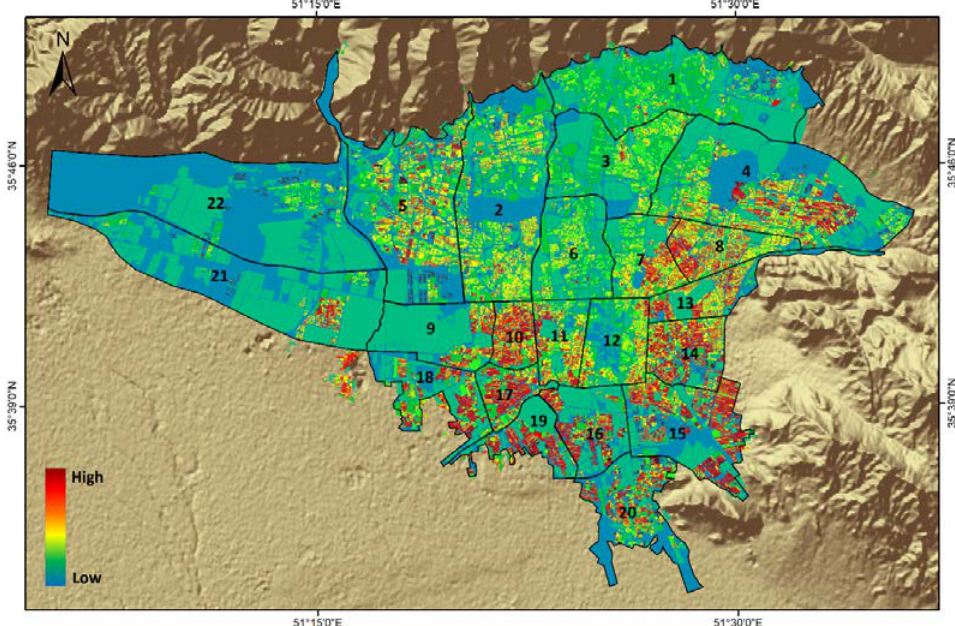
Figure 7. Human exposure (population density) map of Tehran.